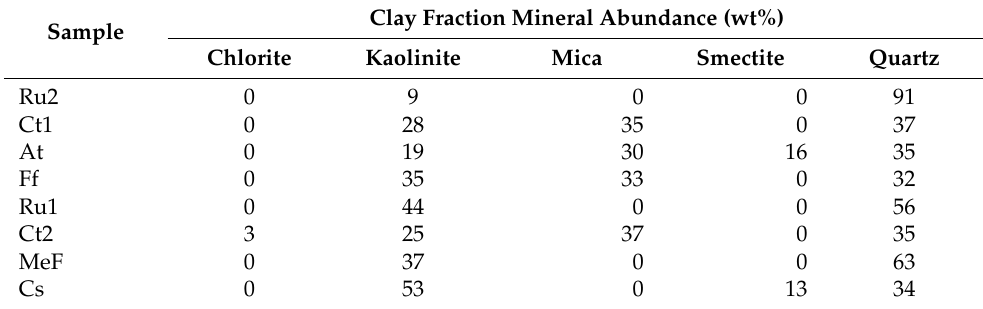
Table 3. Sample water-dispersible clay-fraction mineralogical